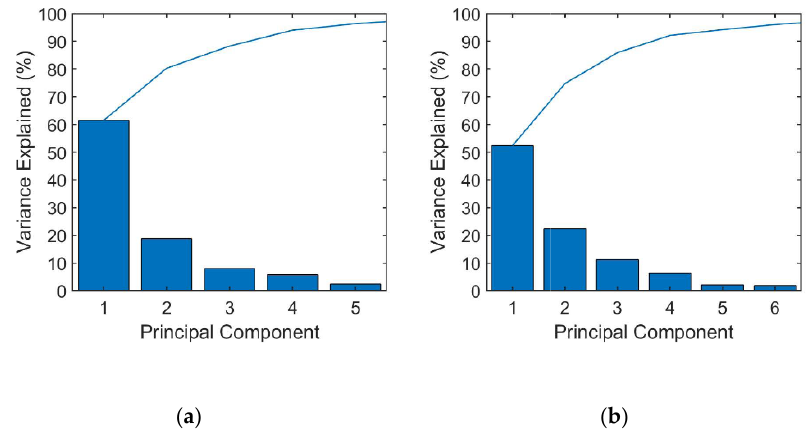
Figure 1. Pareto diagram of two cases after PCA: ( a ) HM1; ( b ) Sandia Flame